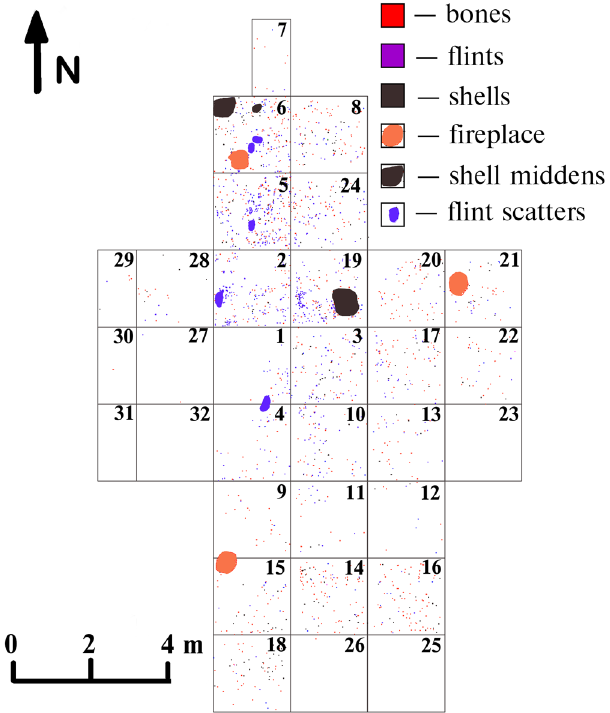
Figure 5: Plan of the layer B in excavation trench